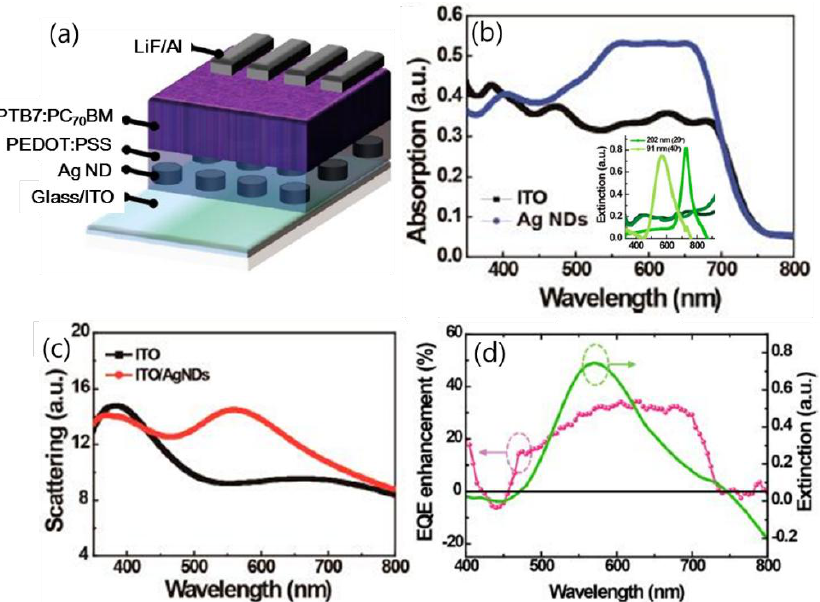
Figure 12. ( a ) Schematic diagram of an OPV device with Ag NDs; ( b ) measured absorption of the PTB7:PC70BM layer coated on different substrates. Absorption of PTB7:PC70BM coated on